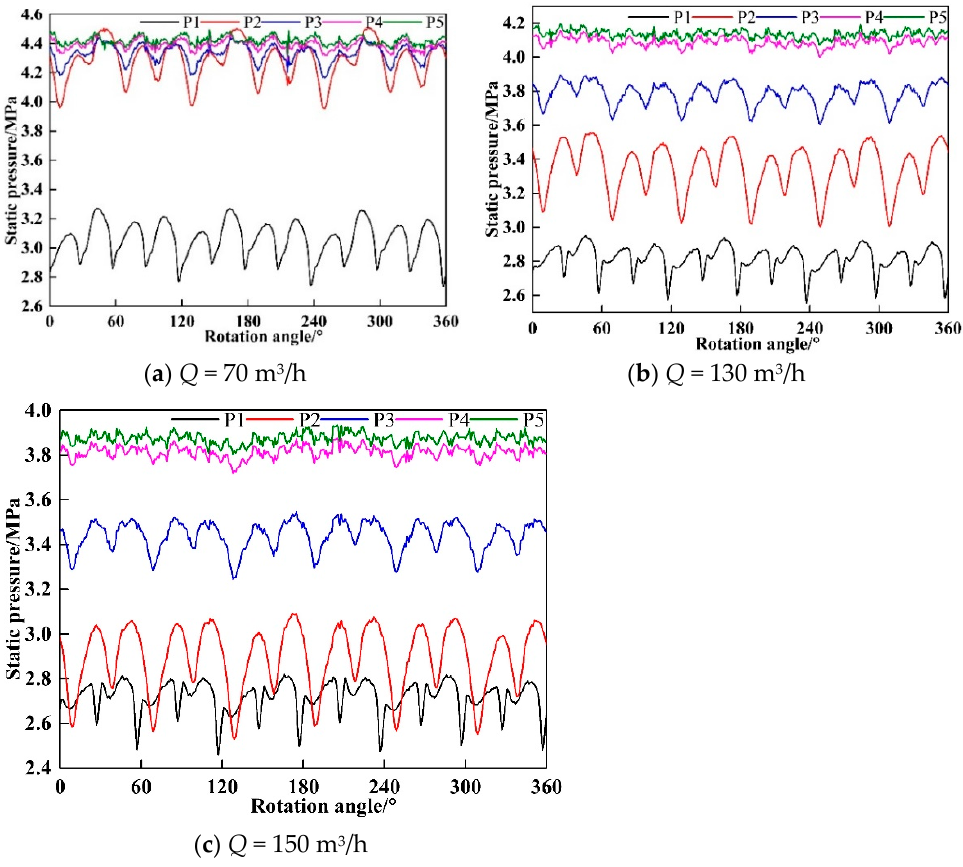
Figure 8. The pressure fluctuations’ value at each monitoring point at different flow rates in guide vane channel.